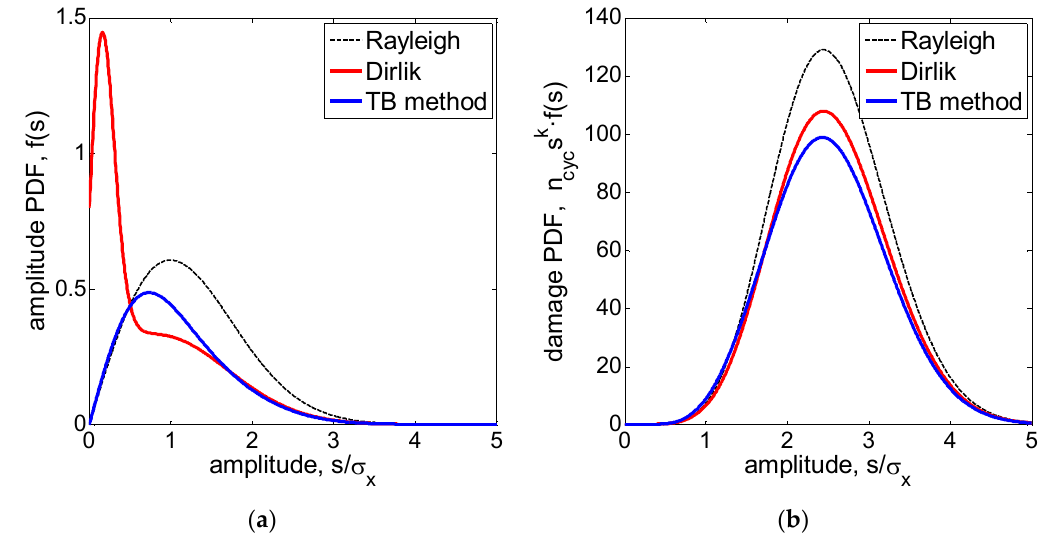
Figure 7. Comparison of ( a ) rainflow probability distributions, ( b ) weighted by the damage per amplitude. The figures refer to parameters r f = 3.233, r A = 0.240 (with α 1 = 0.850, α 2 = 0.600 ).